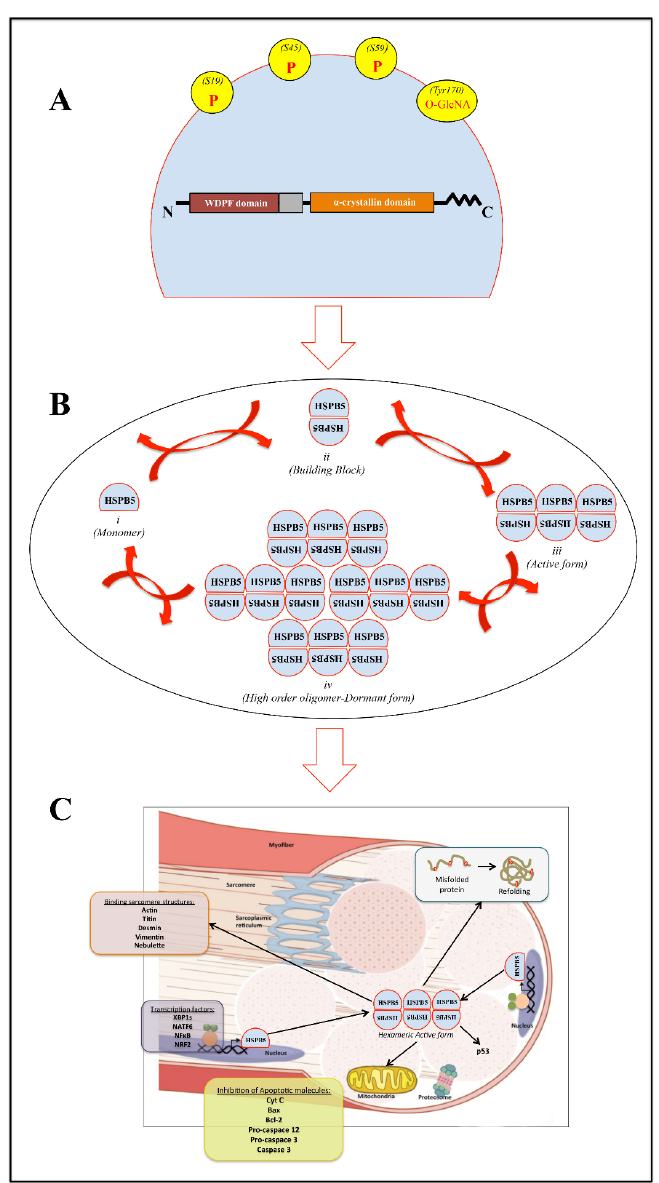
Figure 1. Schematic representation of ( A ) mammalian α B-crystallin protein sequence organization. Gray box: W (tryptophan), D (aspartic acid), P (proline), and F (phenylalanine) (WDPF) amino acid domain; Red bordeaux box: conserved region; orange box: alpha crystallin domain; ΛΛΛΛΛ : flexible domain; P: phosphorylated serine residues; O-GlcNA: O-linked N-acetylglucosamine site at Thr170. ( B ) Exemplified monomer structure (i) of full-length HSPB5. (ii) HSPB5 monomers assemble